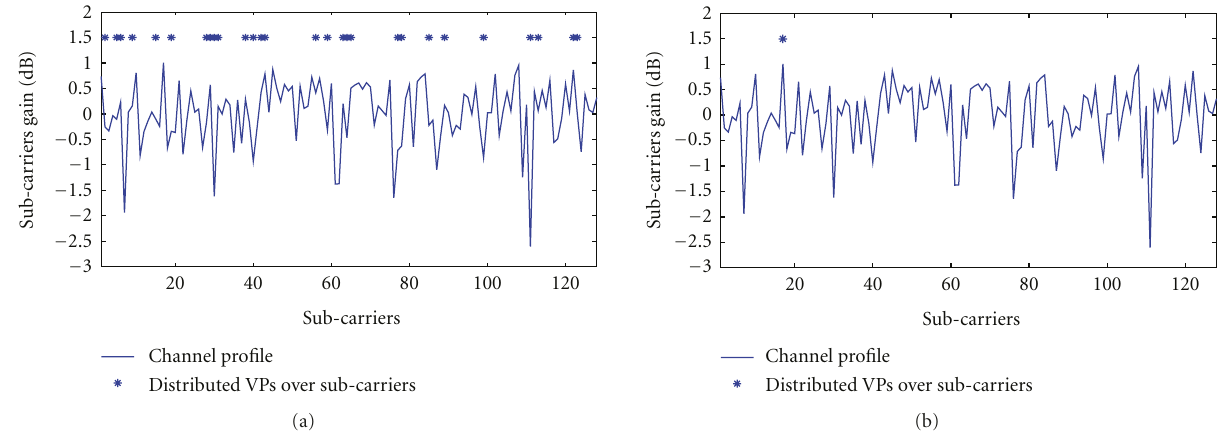
Figure 5: Snapshots of channel profile of TD and TR links and distributed VPs for a single user (a) before convergence and (b) after